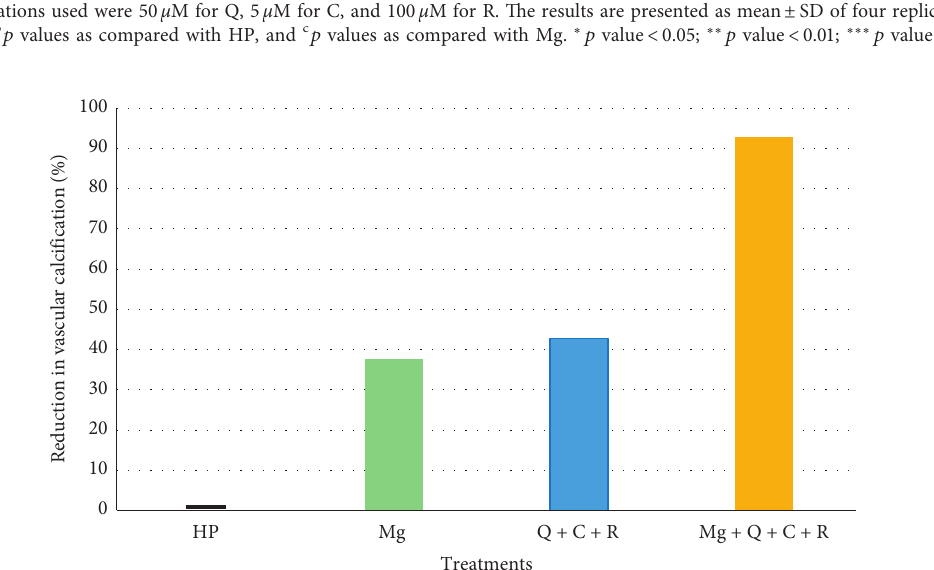
Figure 1: Percent reduction of vascular calcification in rVSMCs incubated in the HP medium by Mg, Q+C+R, and Mg+Q+C +R.